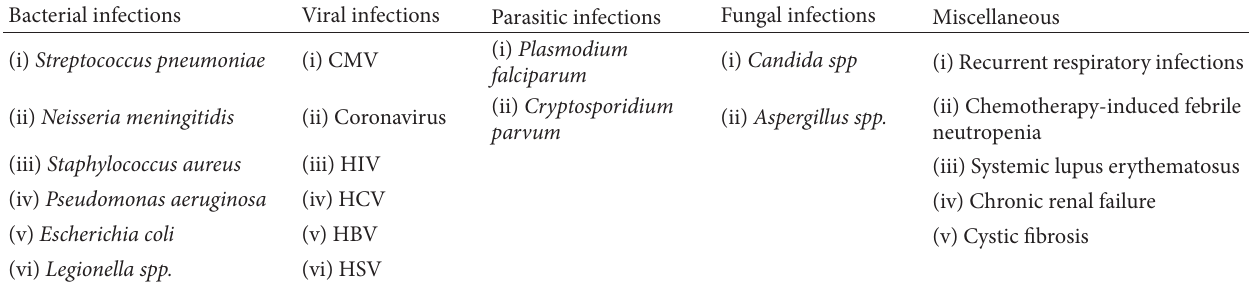
Table 1: MBL deficiency and susceptibility to diseases (human and animal